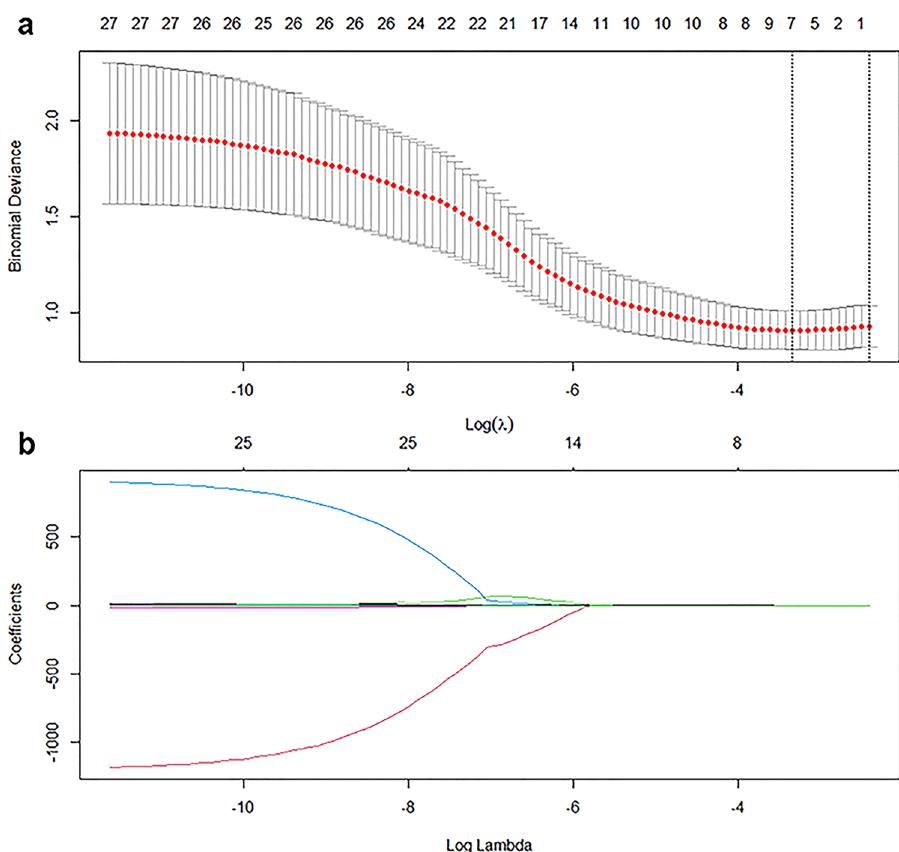
Figure 5. Feature selection was performed using the least absolute shrinkage and selection operator (LASSO) regression model. ( a ) Tuning parameter (λ) selection in the LASSO model used fivefold cross-validation via minimum criteria. Vertical lines were drawn at the optimal values using the minimum criteria and 1 standard error of the minimum criteria. The optimal λ value of 0.0356 with log (λ) = − 3.3359 was chosen. ( b ) LASSO coefficient profiles of the 27 selected features. A coefficient profile plot was generated versus the selected log (λ) value using fivefold cross-validation; seven selected features with nonzero coefficients were